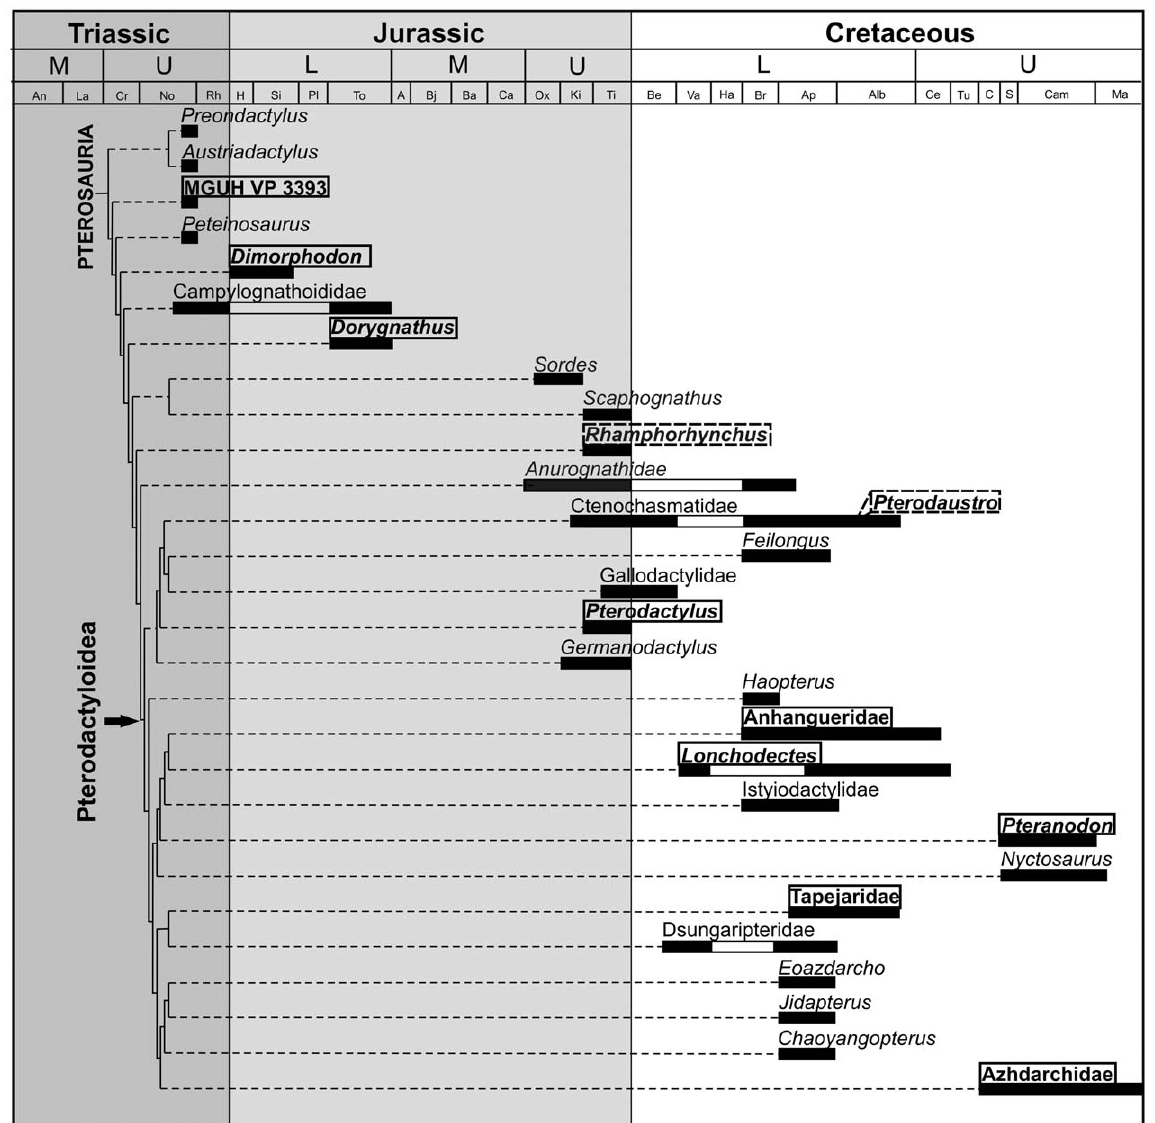
Figure 8. Phylogenetic interrelationships, temporal ranges and general bone histological characters of different members of Pterosauria. Taxa are specified at generic or family level. Taxa that have been histologically investigated so far are framed in rectangles. Those framed by rectangles of solid line have predominantly fibrolamellar bone of varying vascularity degree in the majority of the cortex, occasionally with LAGs and EFS indicating dramatic slowing down of growth in late ontogenetic stages, in which the onset of flight may have occurred. The two genera distinguished by frames of broken lines, Rhamphorhynchus and the ctenochasmatid Pterodaustro differ from the latter in revealing fibrolamellar bone only in juvenile stages and parallel-fibred bone with LAGs in later stages of development. We hypothesize that the early slowing down of growth in these genera is due to the relatively early onset of powered flight. Phylogenetic interrelationships without implications for divergence times are modified after [15] for non-pterodactyloids, and after [66] for Pterodactyloidea. Temporal ranges and chart are modified after [68–70].